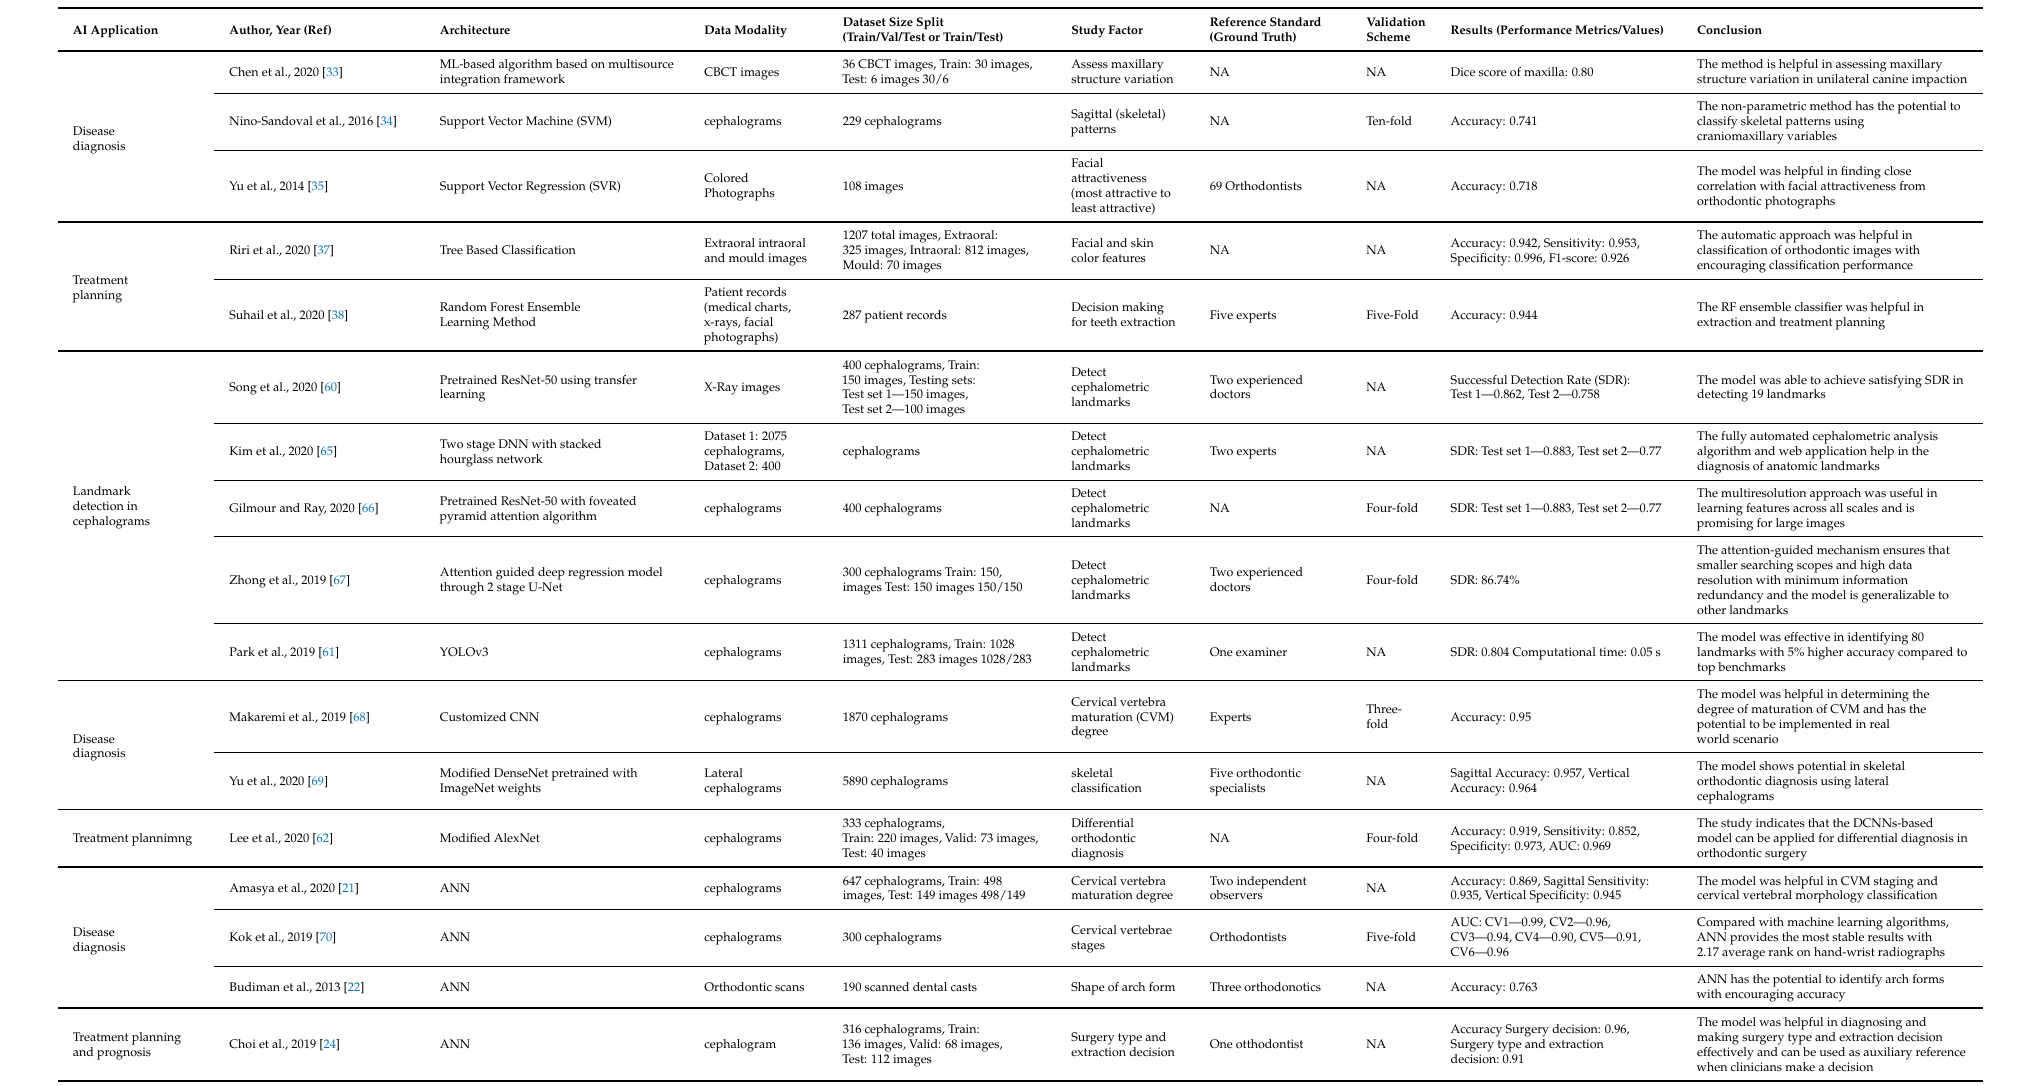
Table 5. Summary of related studies for AI application in